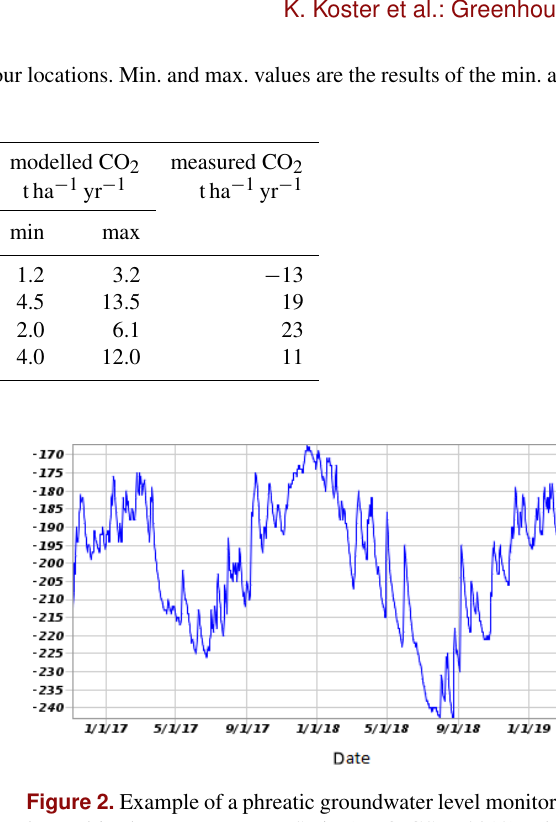
Figure 2. Example of a phreatic groundwater level monitoring well located in the peat area near Stein (TNO-GSN, 2019). The y -axis indicates elevation in cm + MSL; the surface elevation is 1.66m − MSL. Low phreatic level during the summer of 2017 was ca. − 2 . 25m + MSL, whereas the phreatic level dropped during the 2018 extreme summer to − 2 .